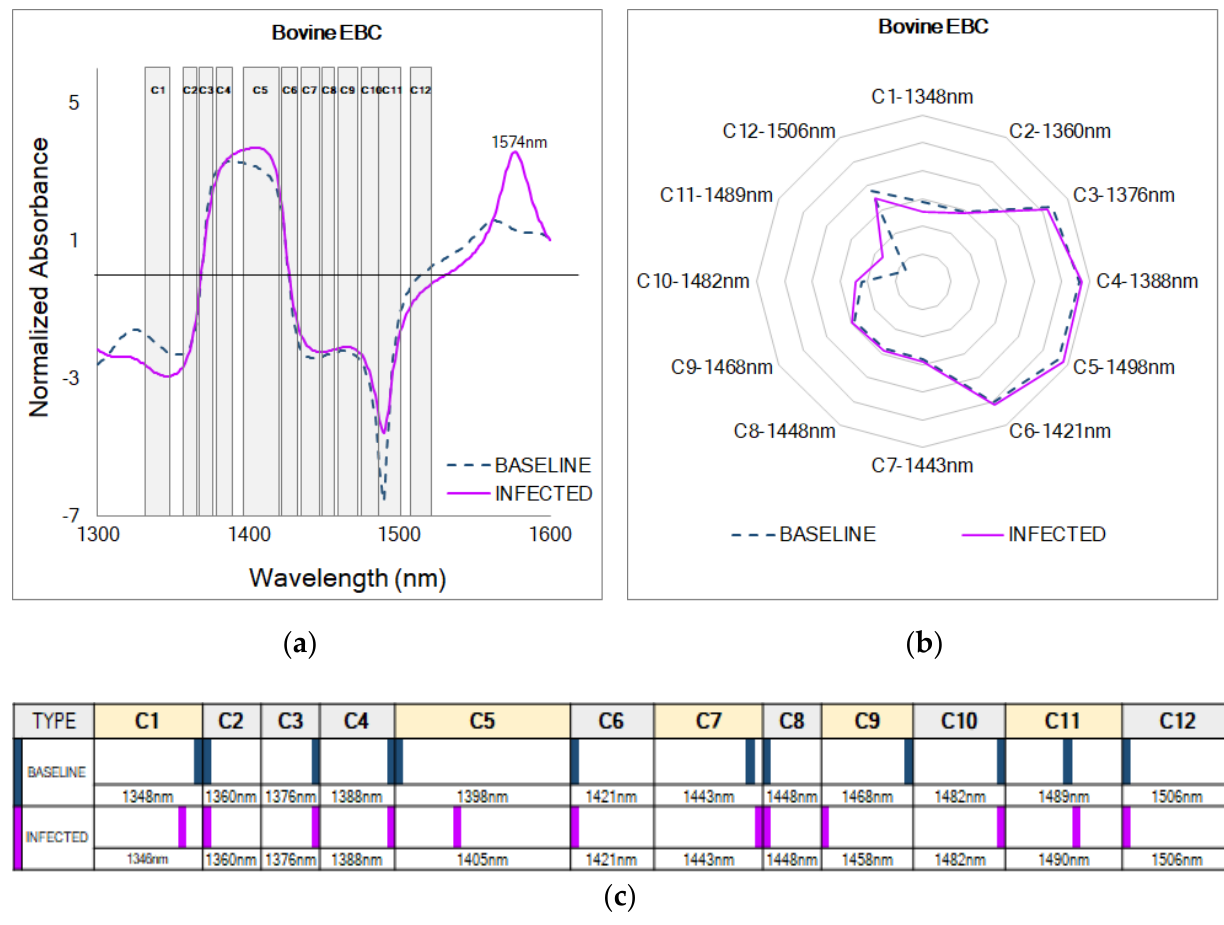
Figure 3. aquaphotomics of EBC from dairy calves infected with BRSV. ( a ) Normalized absorbance for samples from the baseline ( n = 100) and infected ( n = 100) stages from all the calves ( n = 5) challenged in this study. ( b ) Aquagram created with the key WABS from the baseline stage. ( c ) WAMACS barcode showing chemical shifts.